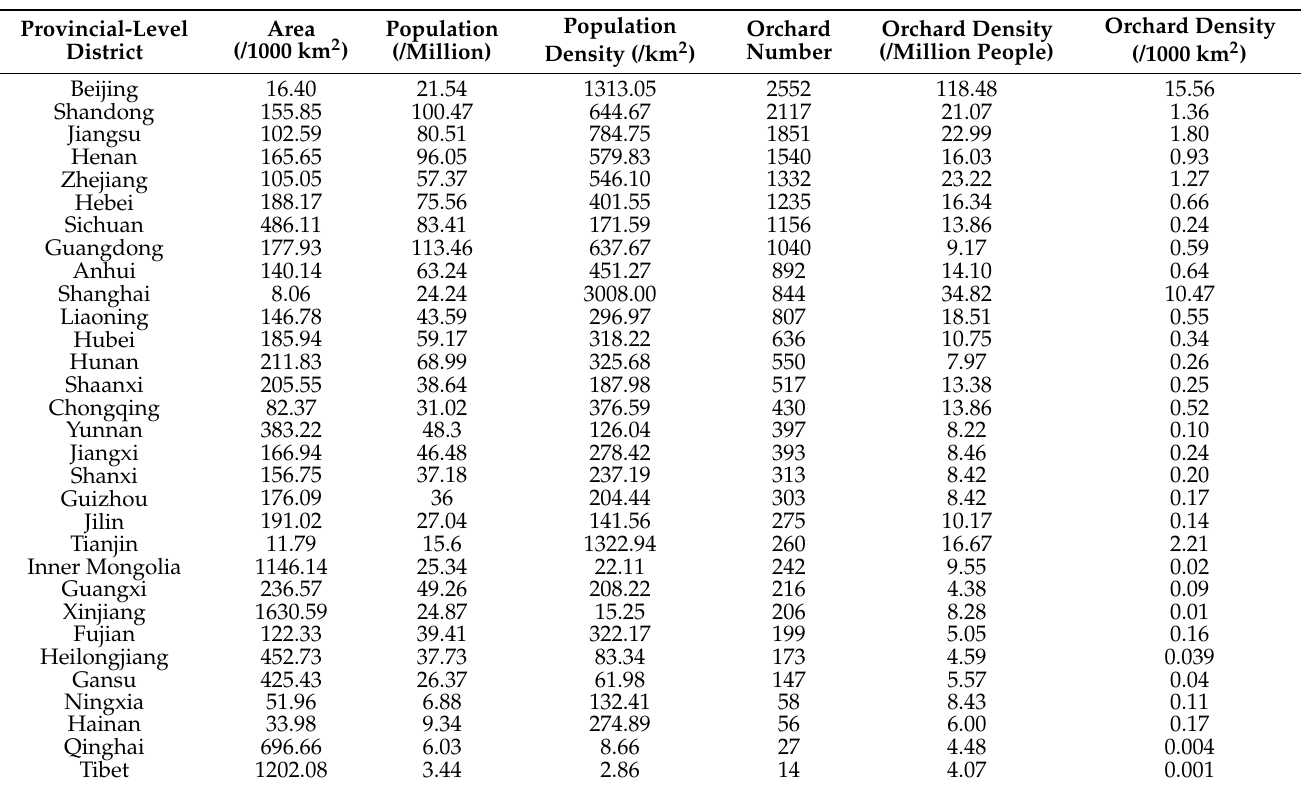
Table A1. The statistics of picking orchards in China’s provincial-level administrative districts. Area (/1000 km 2 )